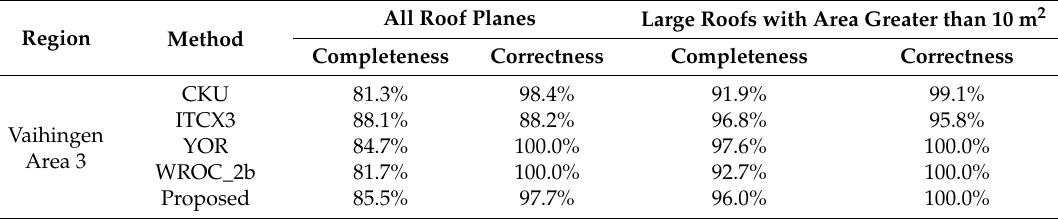
Table 7. Comparison of the final reconstruction performance (per-roof plane).